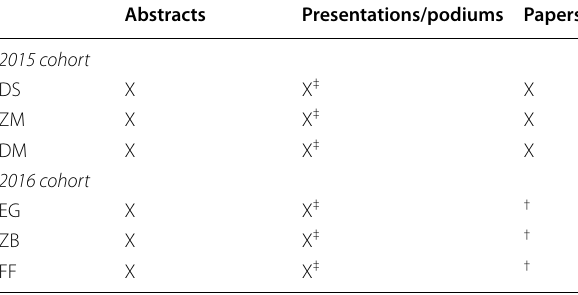
Table 5 Composite academic